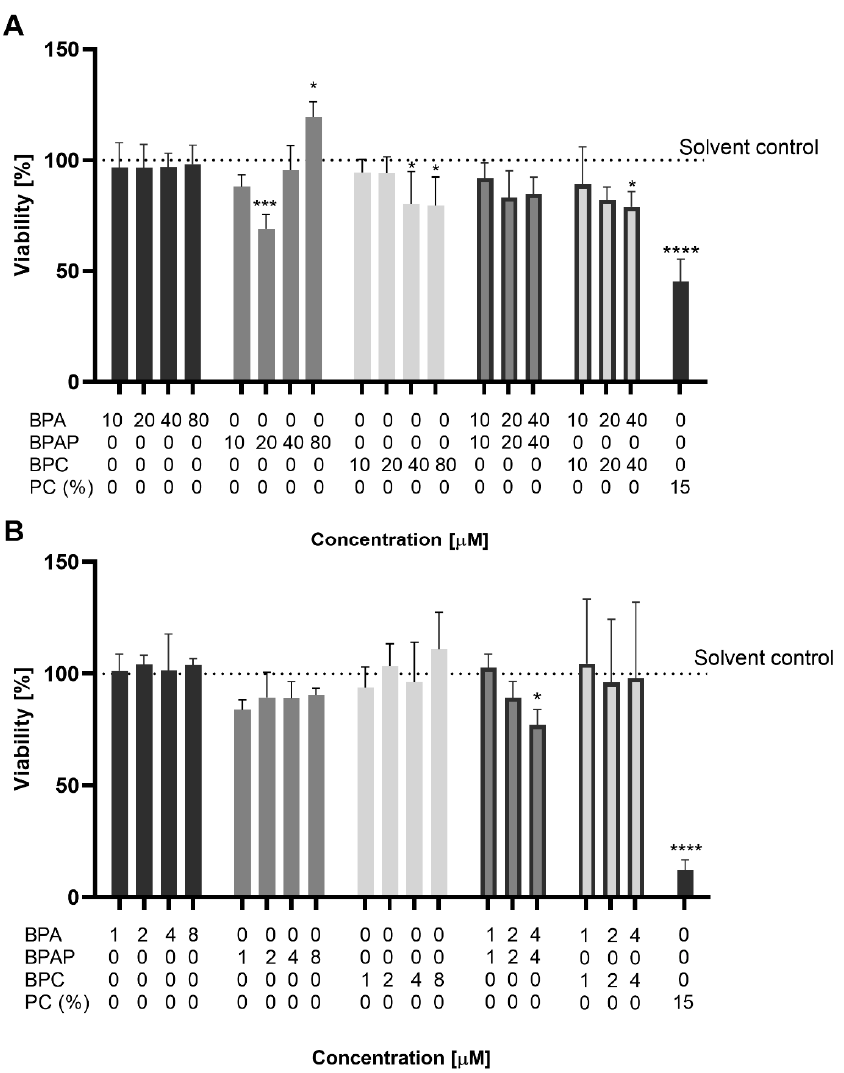
Figure 2. Viability of cells in HepG2 spheroids (MTS assay) after 24 h ( A ) and 96 h ( B ) exposure to BPA, BPAP, BPC and their binary mixtures. PC—positive control (15 % DMSO). * signi fi cantly different from solvent control, * p < 0.05; *** p < 0.001; **** p > 0.0001 (one-way ANOVA; Dunnett’s multiple comparison test).